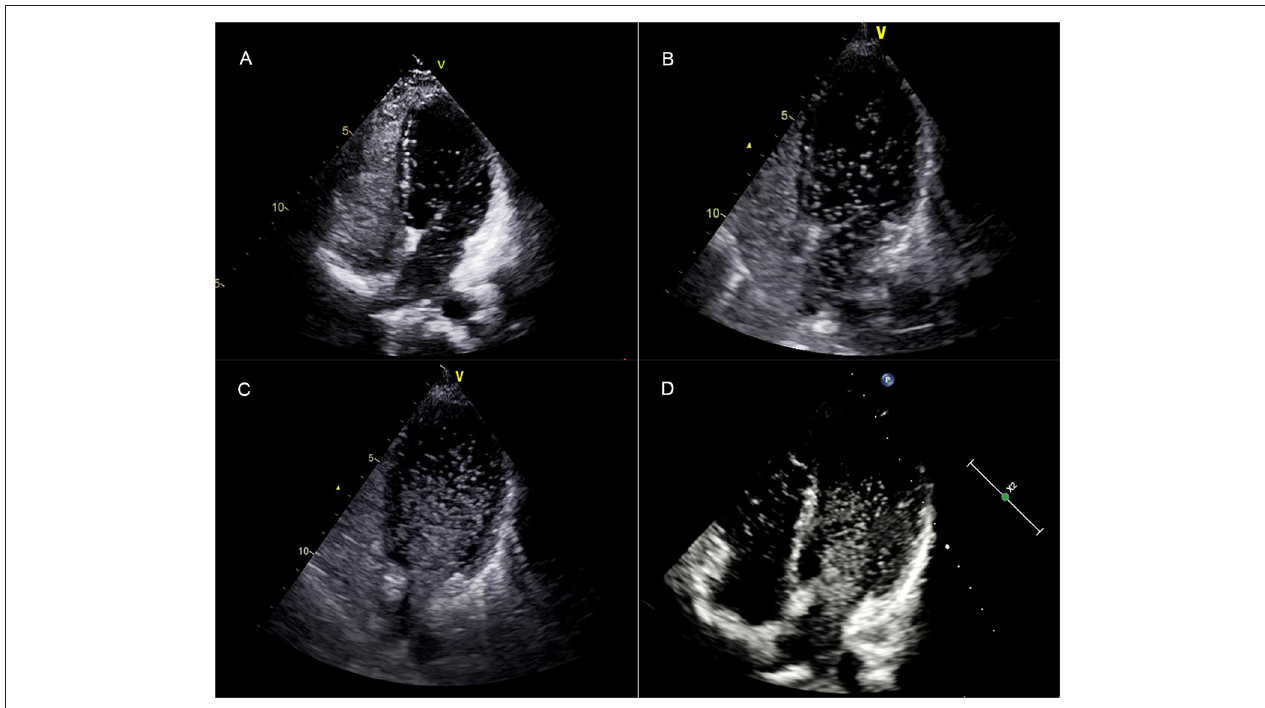
FIGURE 3 | After complete opacification of the right atrium, the TTTE showed the microbubbles in the left chamber after five cardiac cycles in a single frame image. (A–C) correspond to a mild (grade 1), moderate (grade 2), and extensive (grade 3) pulmonary RLS, respectively. (D) showed that the left chamber microbubbles lasted until the right chamber microbubbles disappeared. TTCE, transthoracic contrast echocardiography; RLS, right to left shunt.